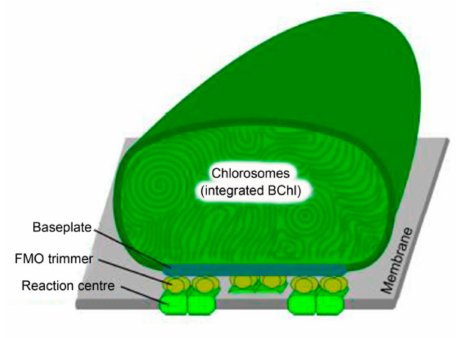
Figure 6. Schematic structure of the photosynthetic apparatus of green sulfur bacteria (the scheme modified from Dost á l, 2014